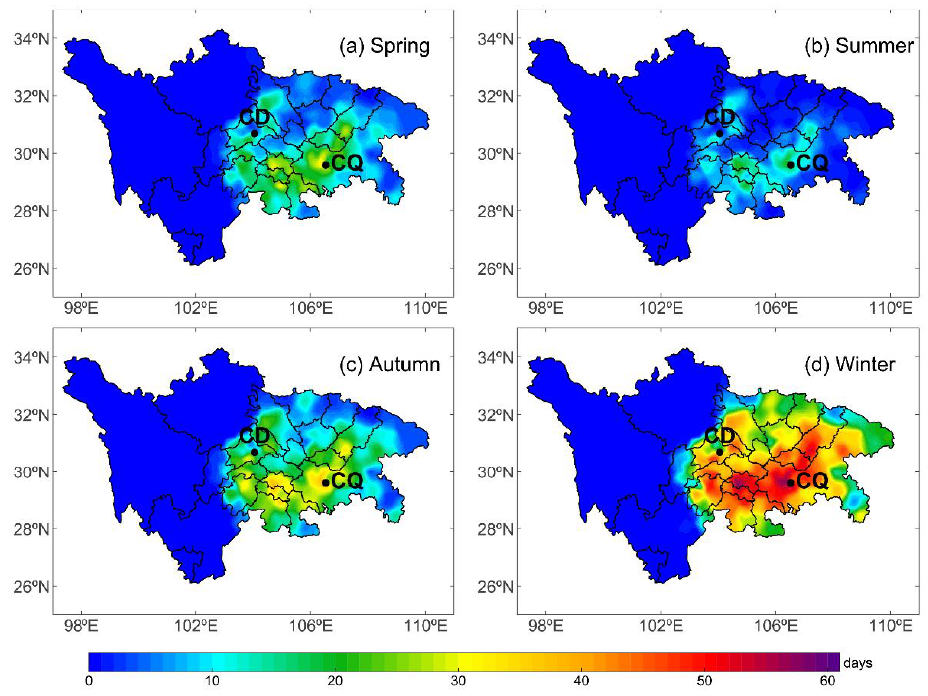
Figure 4. Spatial distributions of the seasonal mean HDs over the Sichuan-Chongqing region for 1980– 2016.